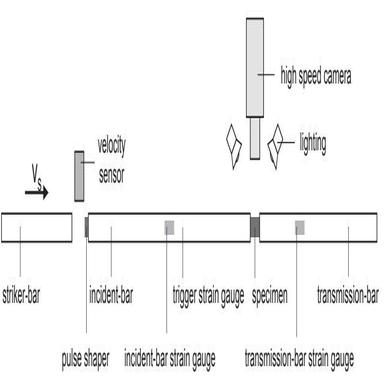
Photo-mechanical setup for dynamic tensile tests (after \).